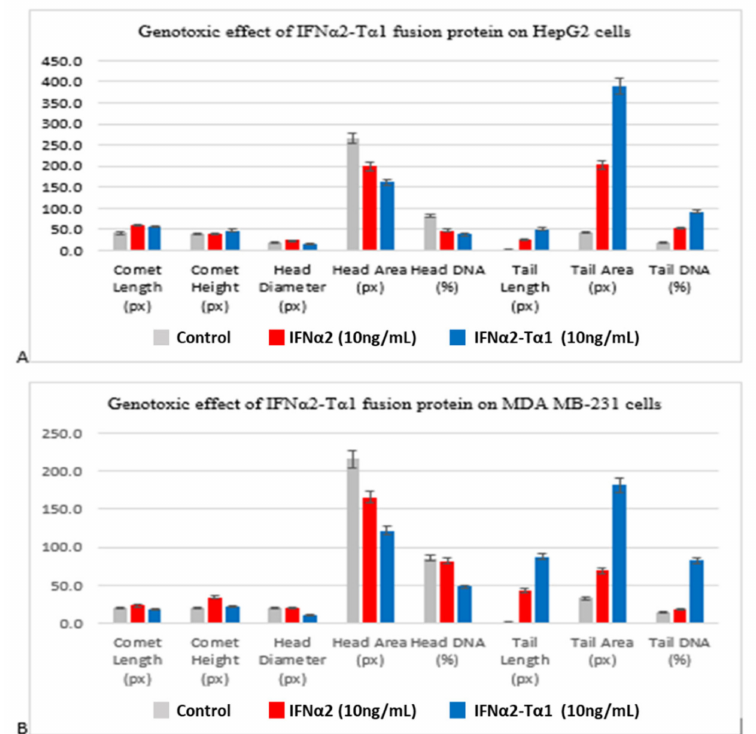
Figure 4. Comparison of eight different comet parameters (comet length, comet height, head diameter, head area, head DNA (%), tail length, tail area and tail DNA (%)) of IFN α 2–T α 1, IFN α 2 and control HepG2 cells ( A ) and MDA-MB-231 cells ( B ). The graphs clearly show that for both cell lines, tail length, tail area and % tail DNA are higher in IFN α 2–T α 1-treated cells in comparison with IFN α 2 and control cells, indicating more DNA damage in fusion protein-treated cells. Data are represented as Mean ±